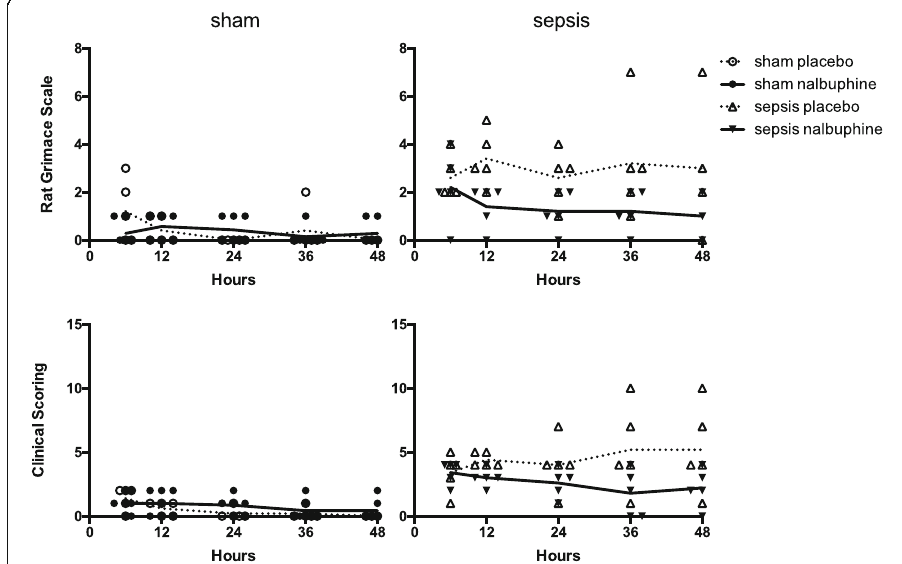
Fig. 5 Rat Grimace Scale and clinical scoring over time. Individual scores are displayed over time. To determine the effect of nalbuphine on behaviour in sham and septic rats, cumulative scores of each animal were compared by ANOVA followed by post-hoc tests. In septic animals, nalbuphine significantly reduced the scores of the Rat Grimace Scale at 24 h (9 ± 2 vs 5 ± 3, p < 0.043), but not the clinical scores at 24 h (12 ± 3 vs 9 ± 2, p = 0.190). Due to mortality and premature termination of experiments, cumulative scores were not compared at 48 h in septic animals. In sham animals, there was no difference in cumulative scores at 24 and 48 h with and without nalbuphine. Data is shown as mean ± standard